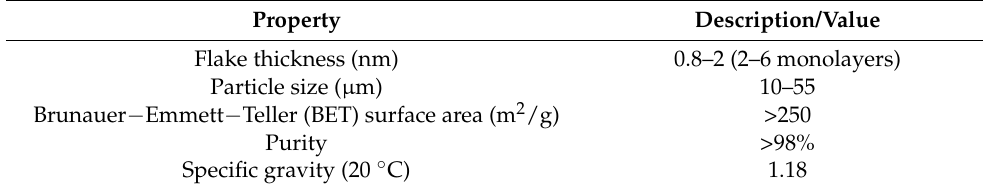
Table 1. Properties of the graphene incorporated into the polymeric